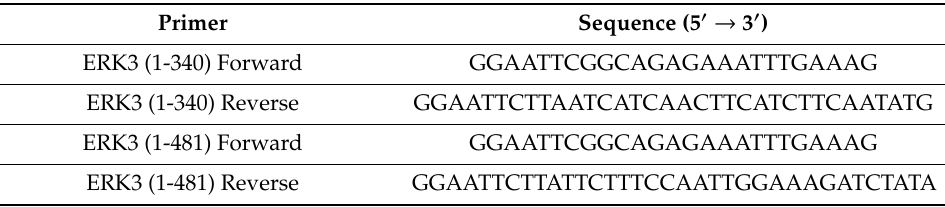
Table 1. Primers used in the